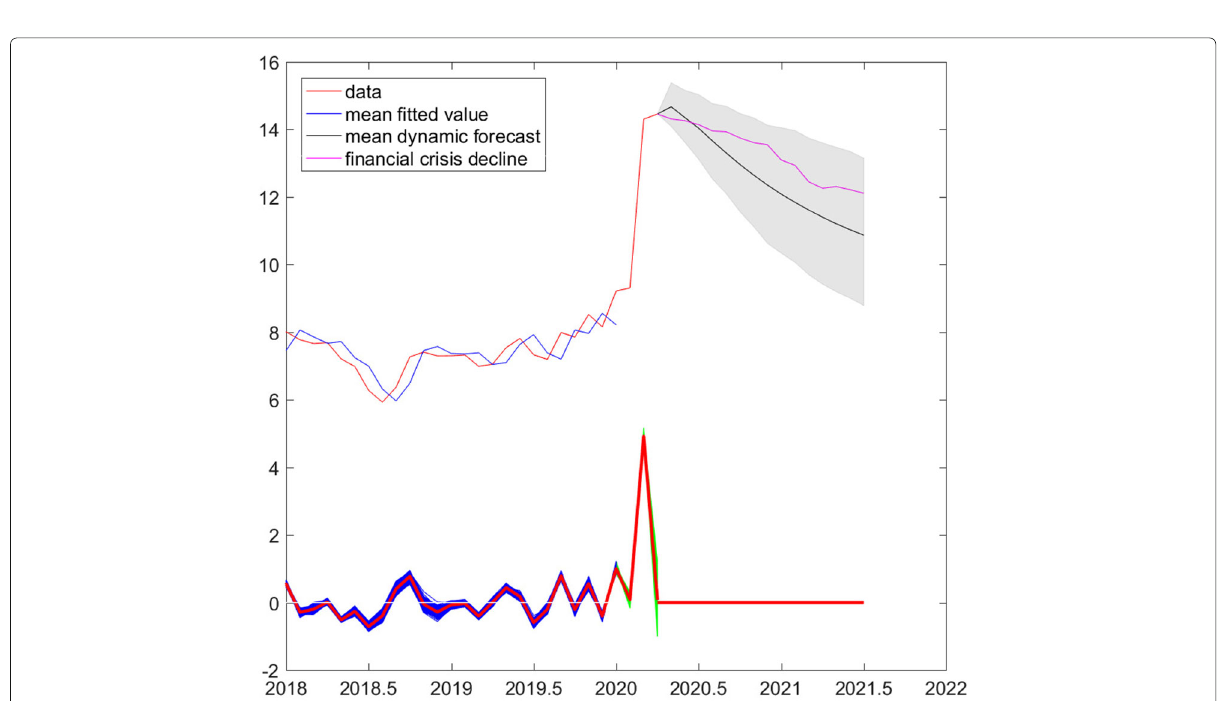
Fig. 5 Log short-time workers, estimation sample: April 2000–January 2020. Top: Data and mean fitted values, mean dynamic forecast, and forecast proportional to the decline after August 2009 (financial crisis decline). Bottom: One-step ahead error (shock), in-sample (blue), out-of-sample (green), mean, and implied out-of-sample May 2020 to July 2021